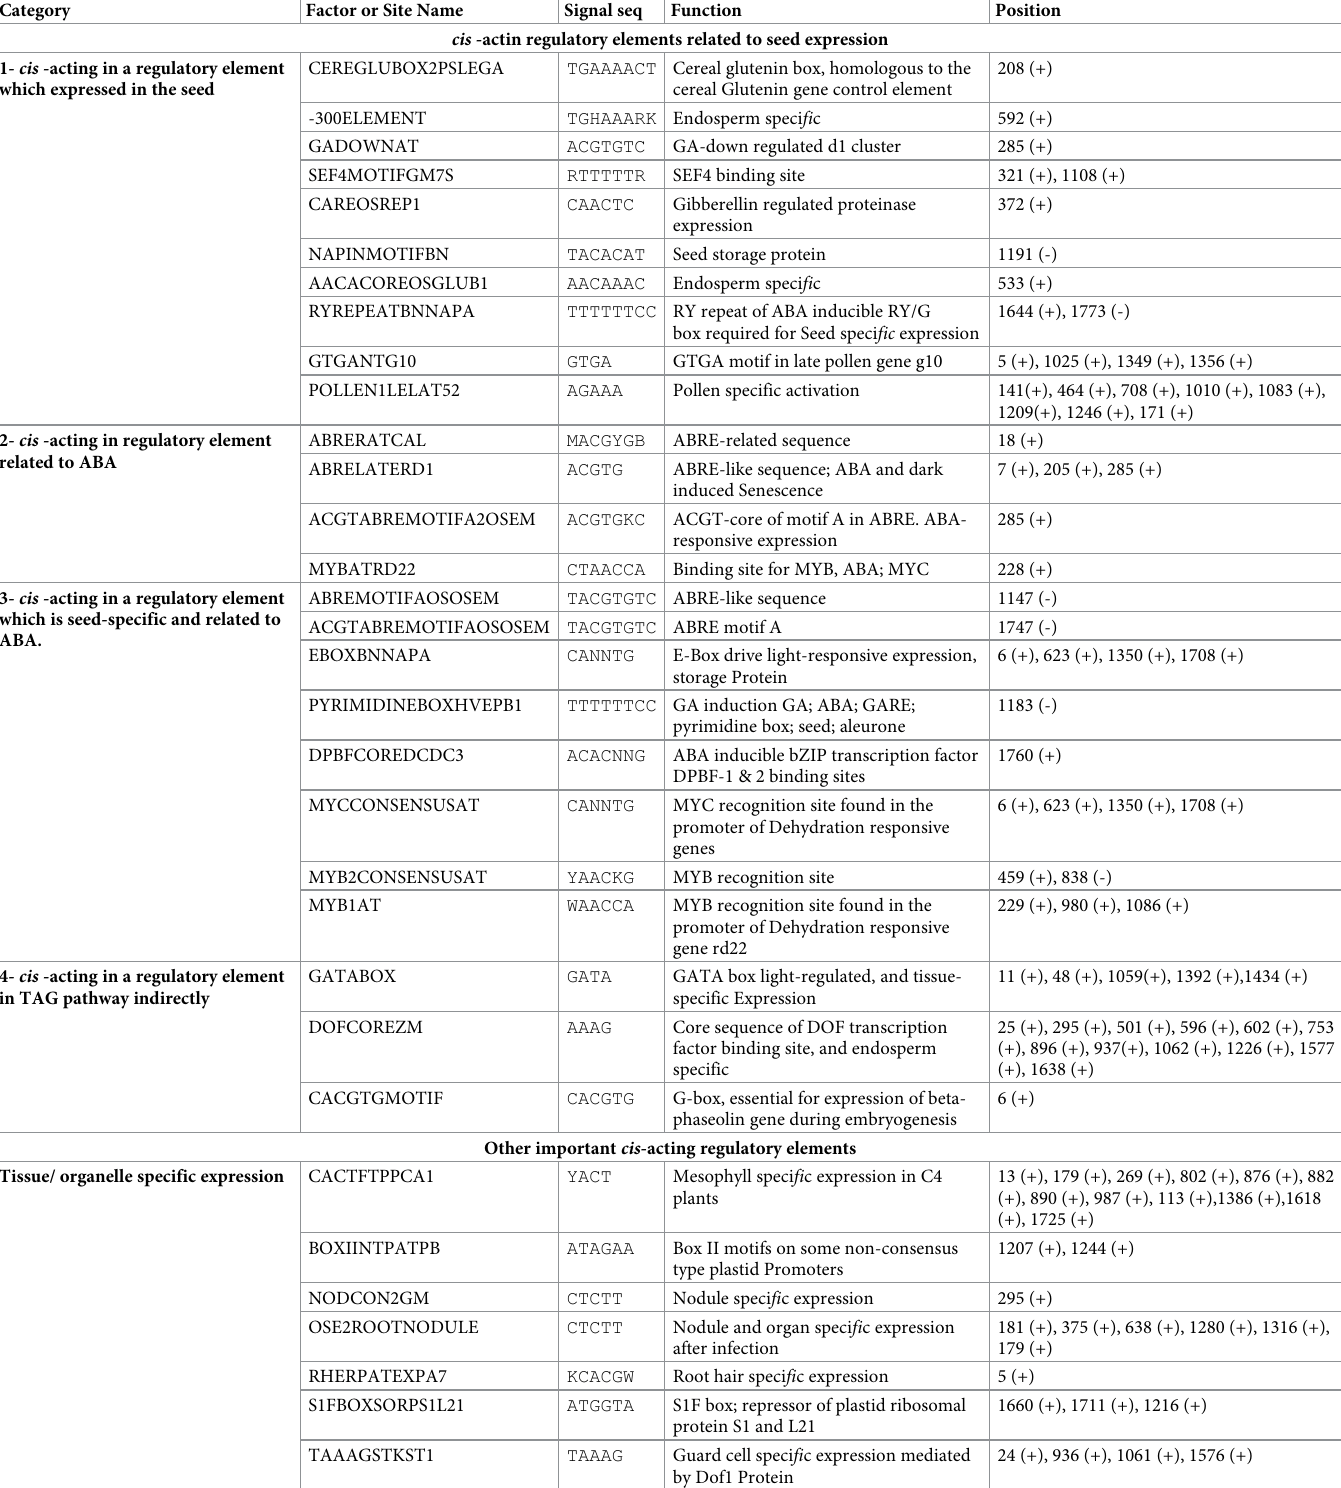
Table 1. Identified cis -acting regulatory elements in SBP using PLANTCARE and PLACE databases.